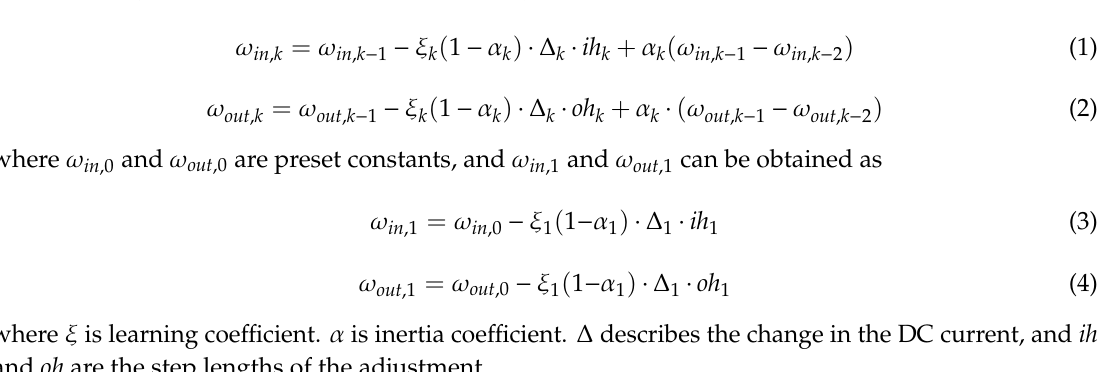
Table 1. The variables within the BP-PID scheme. Symbol Parameter ω in , k The k th iterated weights between the input layer and hidden layer ω out , k The k th iterated weights between the hidden layer and output layer ξ k Learning coe α k Inertia coe ∆ k Change of DC current ih k lengths of the adjustment for ω in , k oh k lengths of the adjustment for ω out ,